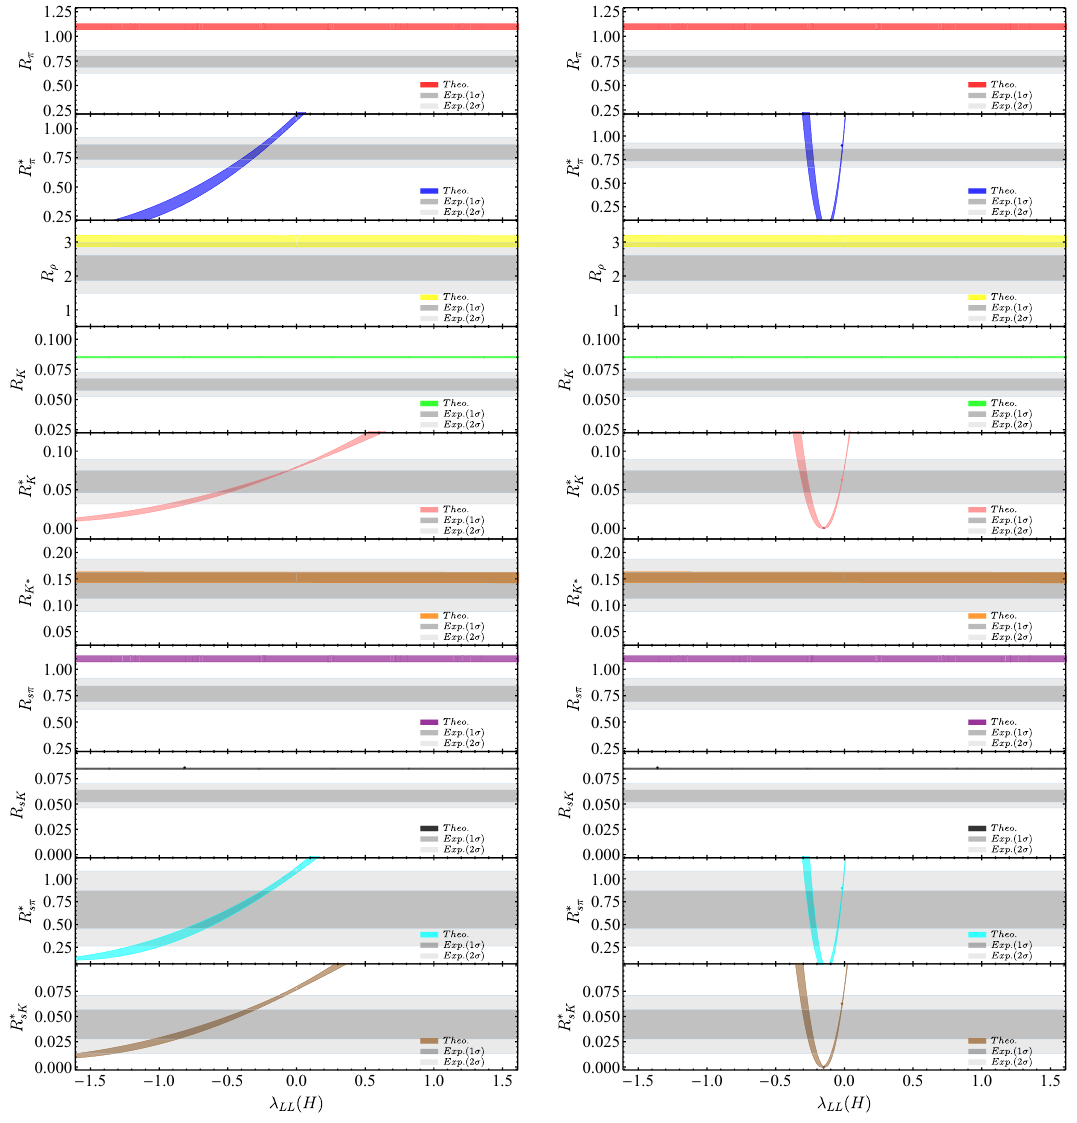
Figure 21 . Same as in figure 17 but for the effective coefficient λ LL ( H ) in the colorless scalar case. ( C SRR ( m ) , C SRR b 2